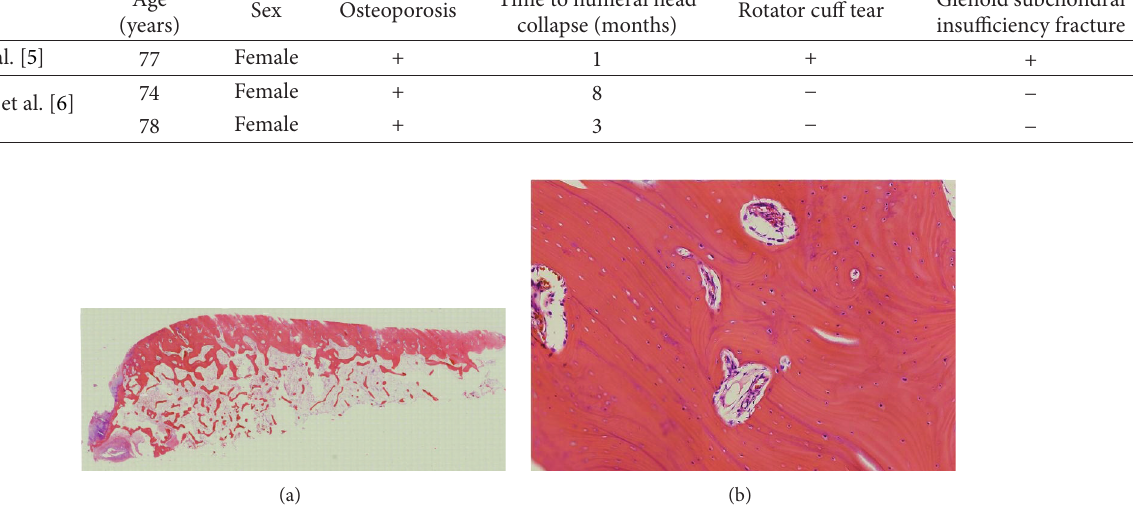
Figure 5: Histologic features of the excised humeral head in patient 2 (hematoxylin-eosin staining). (a) A coronal section of the humeral head exhibits the collapse of the subchondral area and articular cartilage defects ( × 1.25). (b) The bone trabeculae are mostly vital but focally necrotic. New bone formation is seen around the necrotic bone trabeculae ( × 100).